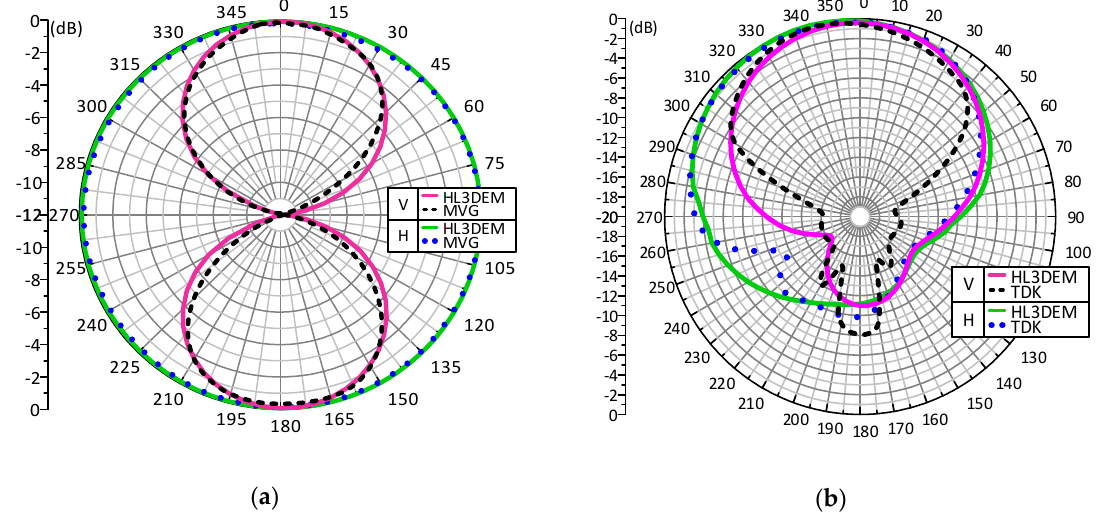
Figure 24. Confirmation of measurement procedure—comparison of measurement results with model diagrams for V polarization: ( a ) Project with omnidirectional antenna; ( b ) Project with directional antenna.